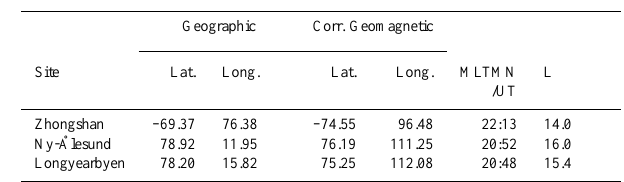
Table 2. Coordinates of the observational